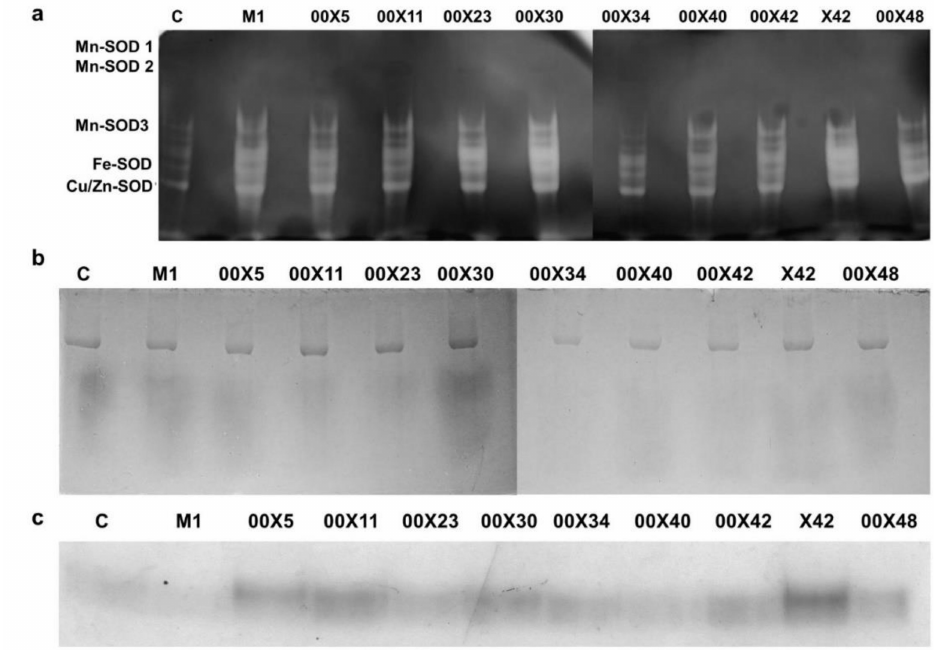
Figure 9. Detection of the activity of superoxide dismutase (SOD) isoenzymes ( a ), peroxidases ( b ), and shikimate dehydrogenase ( c ) after electrophoretic separation under native conditions. The individual SOD isoenzymes were determined in inhibition studies using H 2 O 2 and KCN. Each code (00X5, 00X11, 00X23, 00X30, 00X34, 00X40, 00X42, 00X48, X42, and M1) represents rapeseed plants treated with a